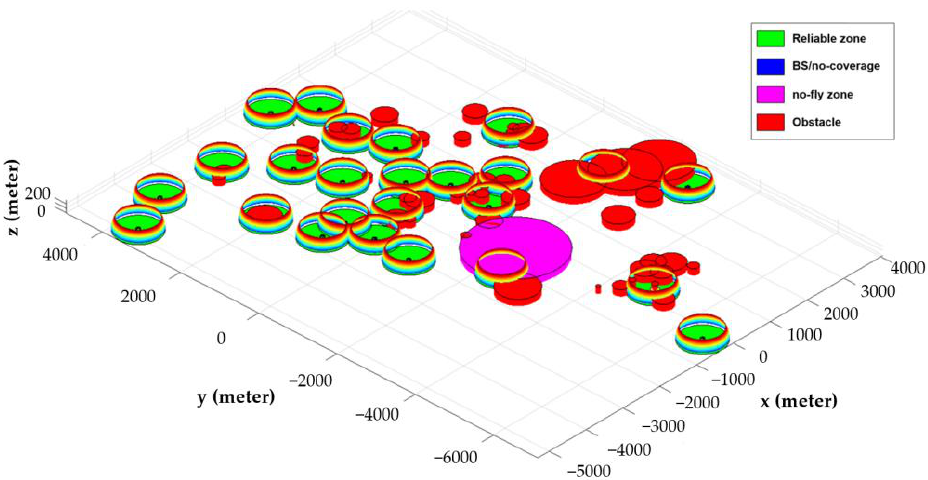
Figure 4. 3D representation of the simulation model for Scenario III in MATLAB environment.